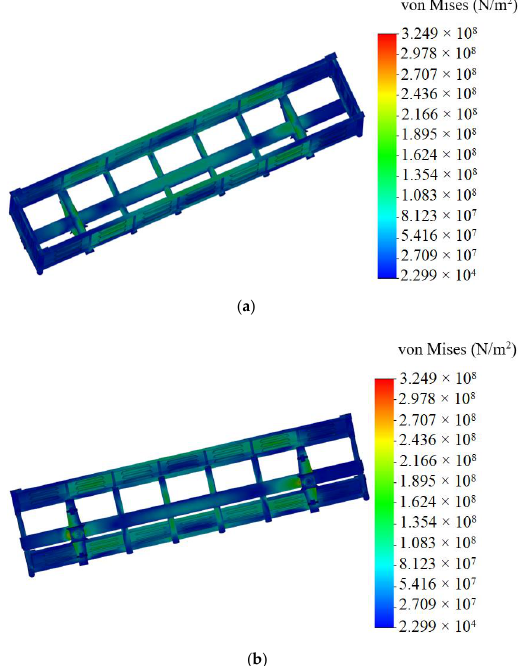
Figure 4. Design diagram of the open wagon.